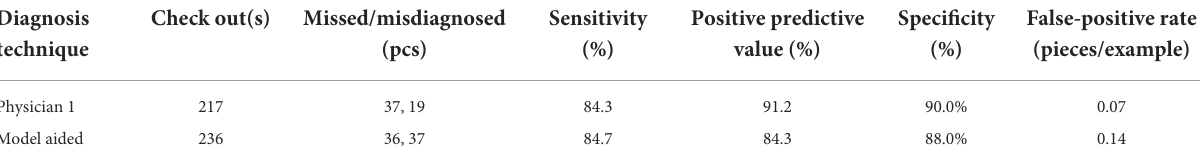
TABLE 5 Comparison of physician detection and model-assisted physician detection results.